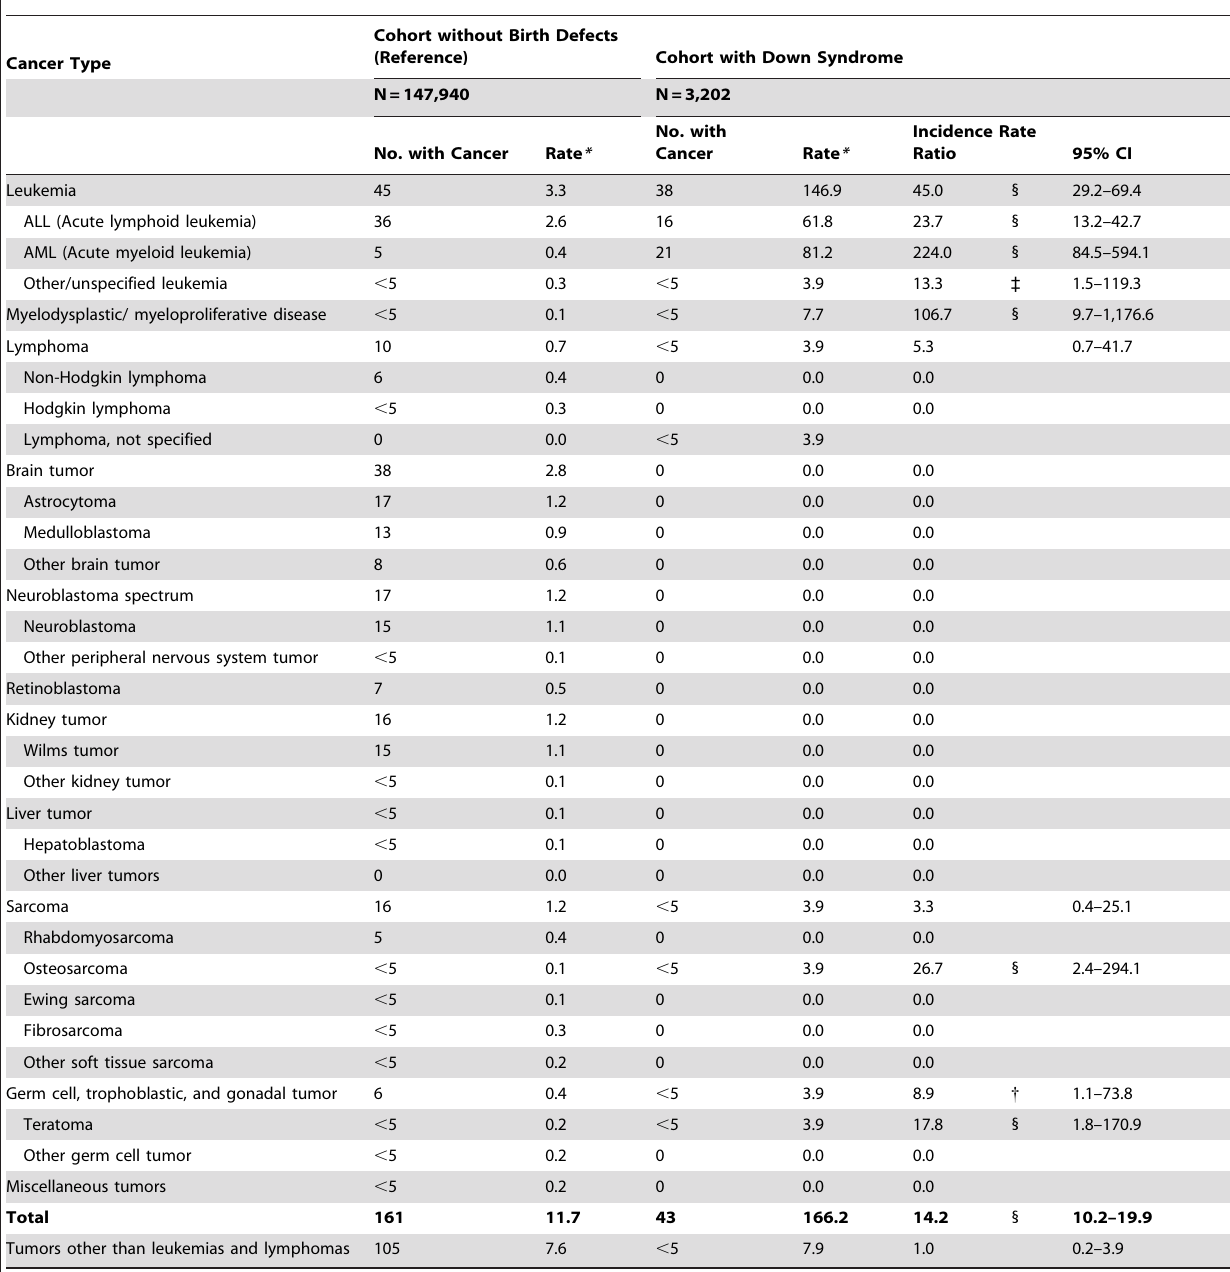
Table 5. Risk for specific types of cancer in children with Down syndrome (trisomy 21), UTAZIA study.